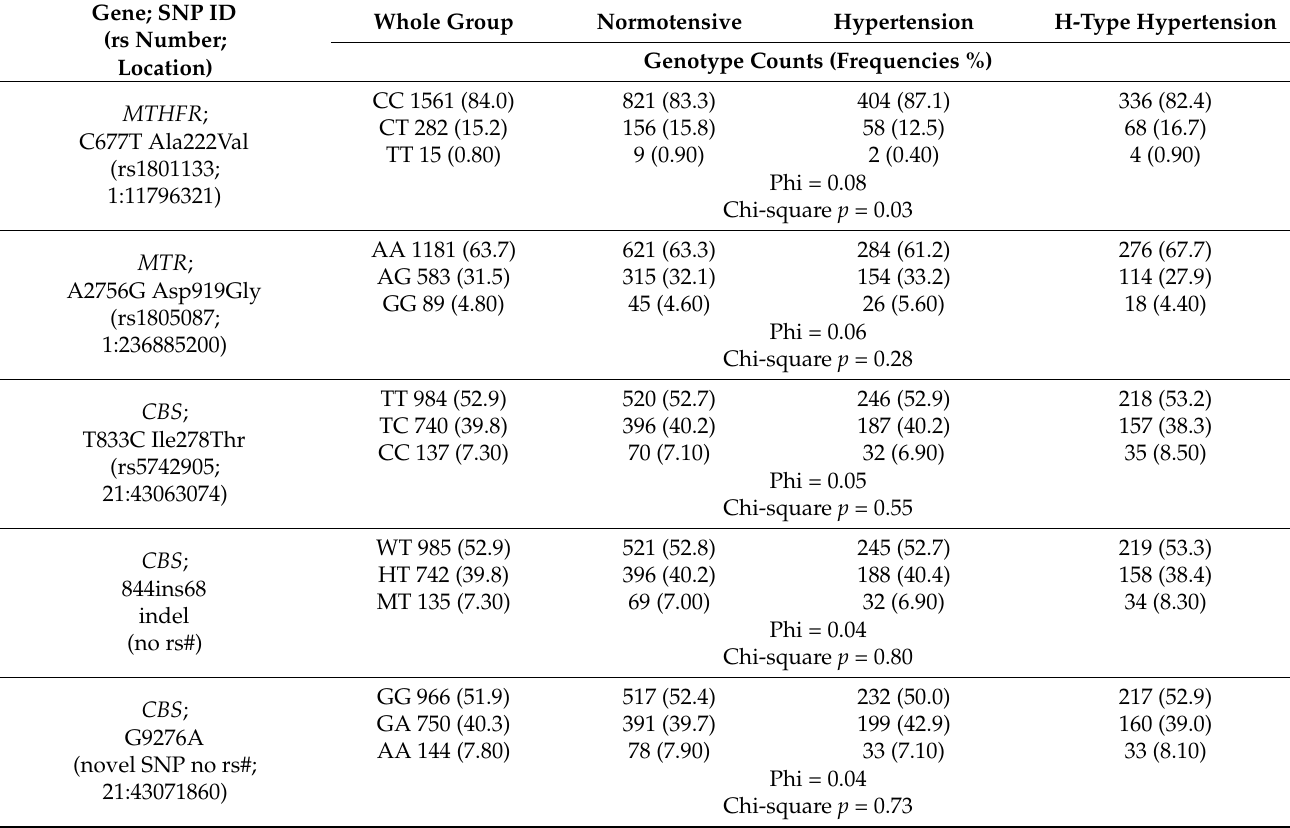
Table 6. Hcy-related SNPs and their genotype frequencies in population subdivisions for blood